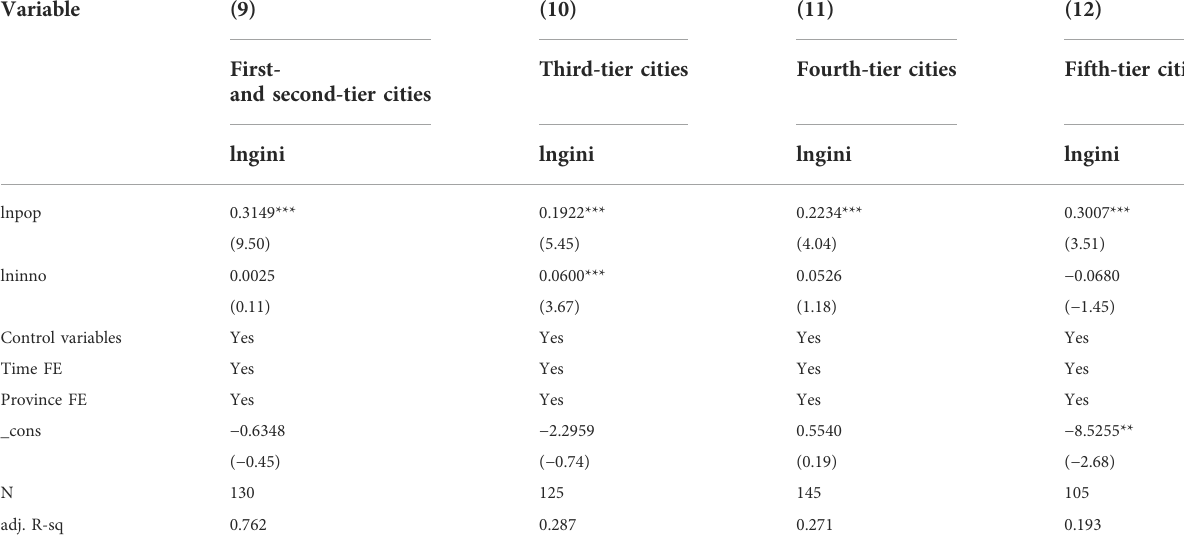
TABLE 5 Regression results at the urban level (based on the New First Tier Cities